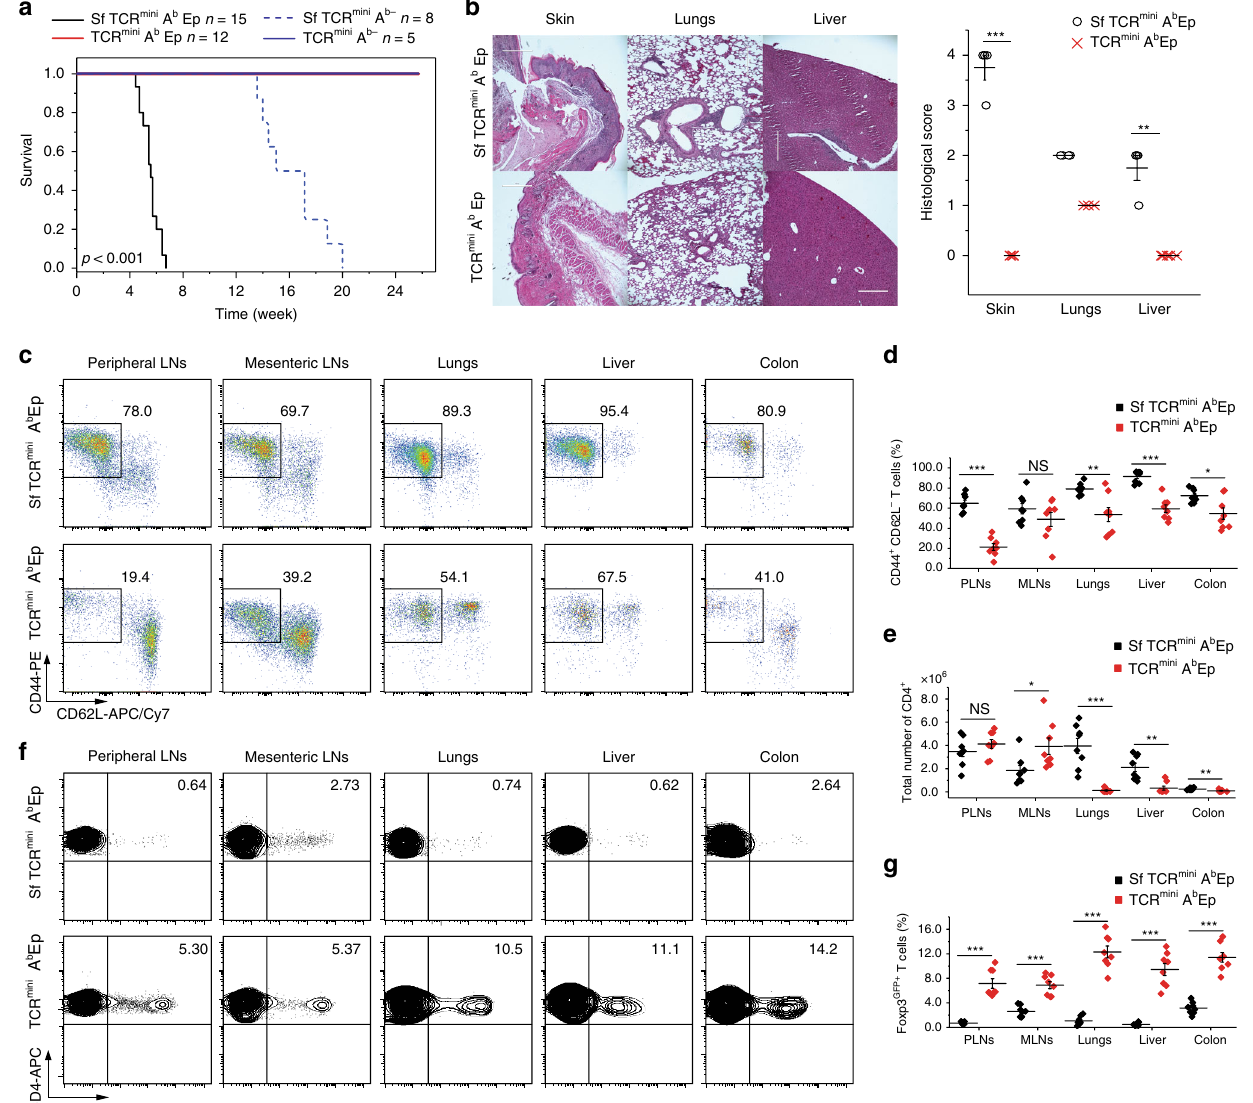
Fig. 4 Single peptide SfTCR mini A b Ep mice succumb to autoimmunity. a Survival curves of SfTCR mini A b Ep, SfTCR mini A b- and corresponding TCR mini strains. b Photomicrographs of H&E stained histological sections of organs from TCR mini A b Ep (lower panel) and SfTCR mini A b Ep mice (upper panel). For details see Fig. 1b. Scale bar 400 μ m. c , d Proportions of CD4 + CD44 + CD62L − cells in indicated mice. e The total number of CD4 + cells and f , g Proportions of CD4 + Foxp3 GFP + cells in indicated organs. All mice were 4-6 weeks old ( n = 5 – 10). Unpaired t -test was applied, and statistical signi fi cance is indicated where appropriate (* p < 0.05, ** p < 0.01, *** p < 0.001, NS-not signi fi cant). Source data are provided in a Source Data fi le. Error bars show